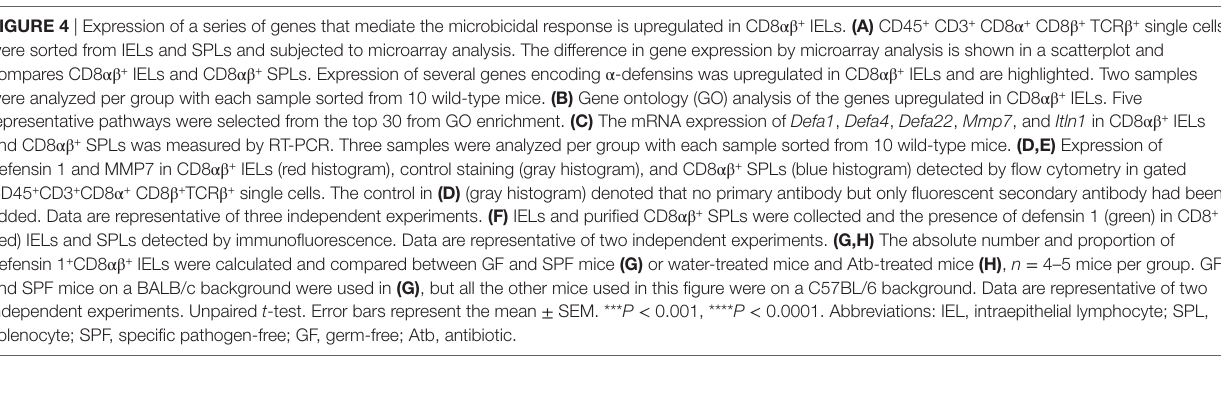
FigUre 4 | Expression of a series of genes that mediate the microbicidal response is upregulated in CD8 αβ + IELs. (a) CD45 + CD3 + CD8 α + CD8 β + TCR β + single cells were sorted from IELs and SPLs and subjected to microarray analysis. The difference in gene expression by microarray analysis is shown in a scatterplot and compares CD8 αβ + IELs and CD8 αβ + SPLs. Expression of several genes encoding α -defensins was upregulated in CD8 αβ + IELs and are highlighted. Two samples were analyzed per group with each sample sorted from 10 wild-type mice. (B) Gene ontology (GO) analysis of the genes upregulated in CD8 αβ + IELs. Five representative pathways were selected from the top 30 from GO enrichment. (c) The mRNA expression of Defa1 , Defa4 , Defa22 , Mmp7 , and Itln1 in CD8 αβ + IELs and CD8 αβ + SPLs was measured by RT-PCR. Three samples were analyzed per group with each sample sorted from 10 wild-type mice. (D,e) Expression of defensin 1 and MMP7 in CD8 αβ + IELs (red histogram), control staining (gray histogram), and CD8 αβ + SPLs (blue histogram) detected by flow cytometry in gated CD45 + CD3 + CD8 α + CD8 β + TCR β + single cells. The control in (D) (gray histogram) denoted that no primary antibody but only fluorescent secondary antibody had been added. Data are representative of three independent experiments. (F) IELs and purified CD8 αβ + SPLs were collected and the presence of defensin 1 (green) in CD8 + (red) IELs and SPLs detected by immunofluorescence. Data are representative of two independent experiments. (g,h) The absolute number and proportion of defensin 1 + CD8 αβ + IELs were calculated and compared between GF and SPF mice (g) or water-treated mice and Atb-treated mice (h) , n = 4–5 mice per group. GF and SPF mice on a BALB/c background were used in (g) , but all the other mice used in this figure were on a C57BL/6 background. Data are representative of two independent experiments. Unpaired t -test. Error bars represent the mean ± SEM. *** P < 0.001, **** P < 0.0001. Abbreviations: IEL, intraepithelial lymphocyte; SPL,